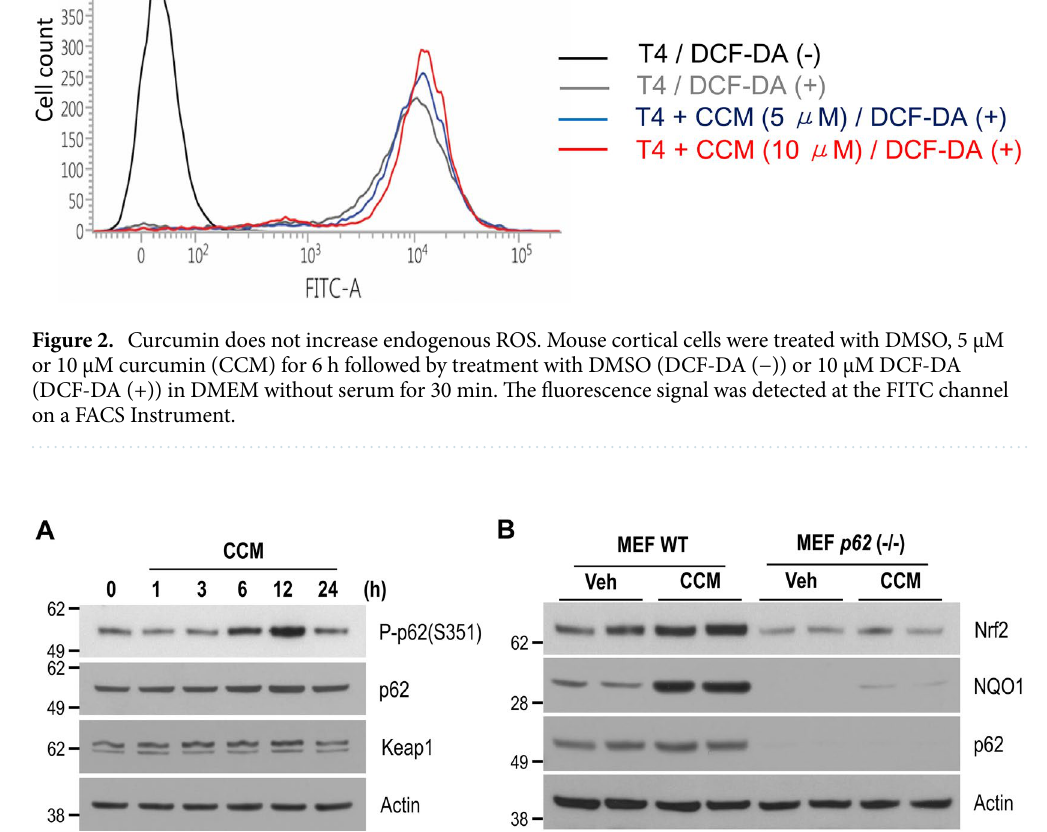
Figure 3. Curcumin-mediated Nrf2 activation is dependent on p62. ( A ) Mouse cortical cells were treated with DMSO (0 h) or 10 μM curcumin (CCM) for the indicated times. The levels of phosphorylated p62 (S351), p62, Keap1, and actin proteins were analyzed by immunoblotting using anti-phospho p62 (S349), p62, Keap1, and actin antibodies, respectively. ( B ) MEFs were treated with DMSO (Veh) or 10 μM curcumin (CCM) for 12 h. The protein levels of Nrf2, NQO1, p62, and actin were analyzed by immunoblotting using anti-Nrf2, NQO1, p62, and actin antibodies, respectively. Full blots are provided in Supplementary Fig.